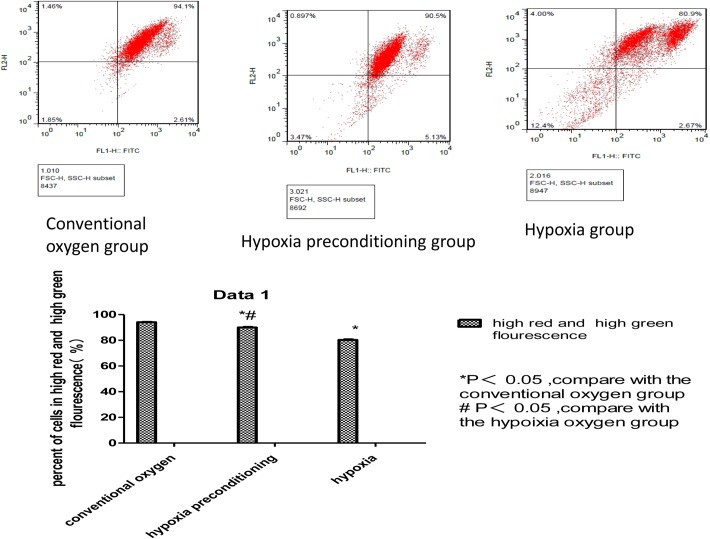
The figure represent the mitochondrial membrane potential of induced Schwann cells in different groups.The points located in the upper-right quadrant represent the number of induced Schwann cells whose mitochondrial membrane potential is not declined. In conventional oxygen group, 94.1±0.2% of the tested induced Schwann cells were in the upper-right quadrant, the hypoxia-preconditioning group, 90.1±0.1% of the tested induced Schwann cells were in the upper-right quadrant, the hypoxia group, 80.6±0.6% of the tested induced Schwann cells were in the upper-right quadrant. The conventional oxygen group had highest ratio of induced Schwann cells whose mitochondrial membrane potential is not declined, and the hypoxia group had lowest ratio of induced Schwann cells whose mitochondrial membrane potential is not declined.